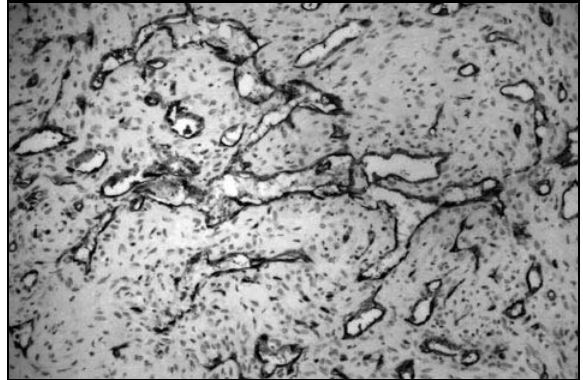
Figura 4 – Expressão do CD-34 pelas células endoteliais. Ausência de marcação nas células neoplásicas (imuno-histoquímica, estreptavidina-biotina-peroxidase – aumento original 200